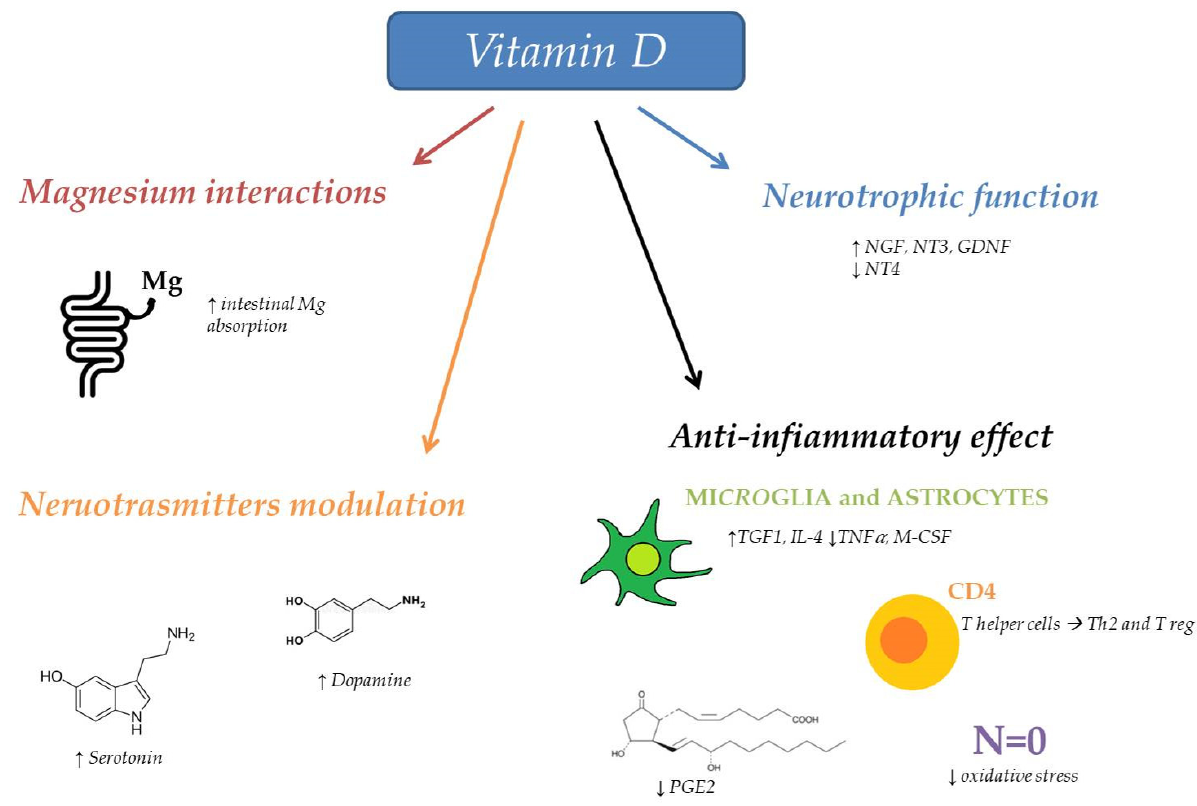
Figure 1. Vitamin D role in headache prevention. Abbreviation: Magnesium (Mg), neural growth factor (NGF), nuerotrophin 3 (NT3), glial cell line derived neurotrophic factor (GDNF), neurotrophin 4 (NT4), transforming growth factor beta 1 (TGF1), interleukin-4 (IL-4), tumor necrosis factor- α ( TNF α ), macrophage colony stimulating factor ( M-CSF